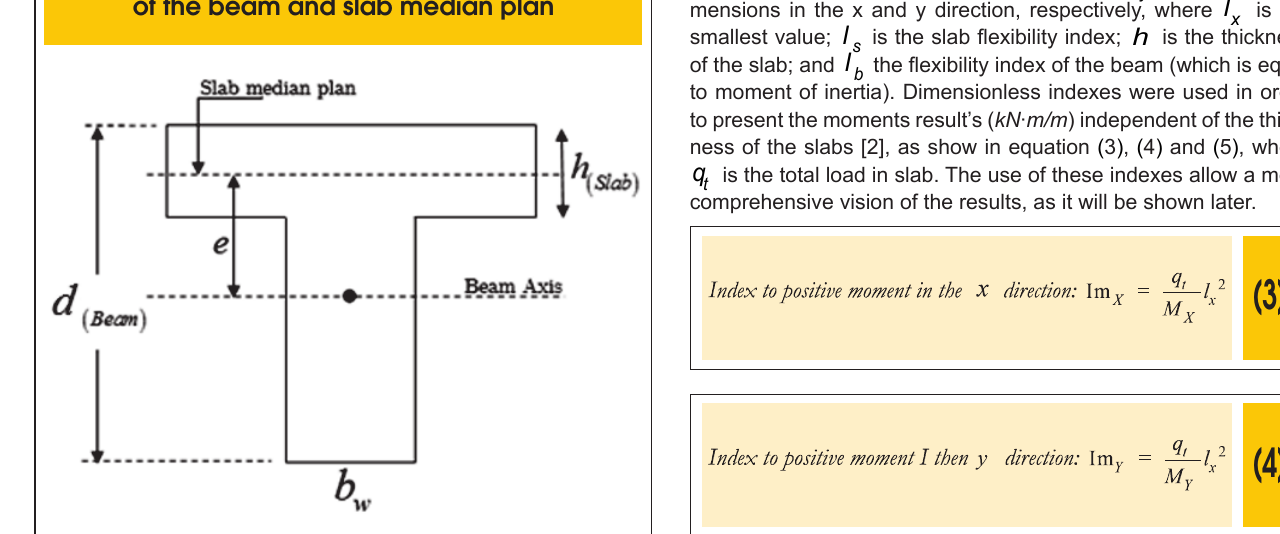
Figure 1 – Eccentricity between the axis of the beam and slab median